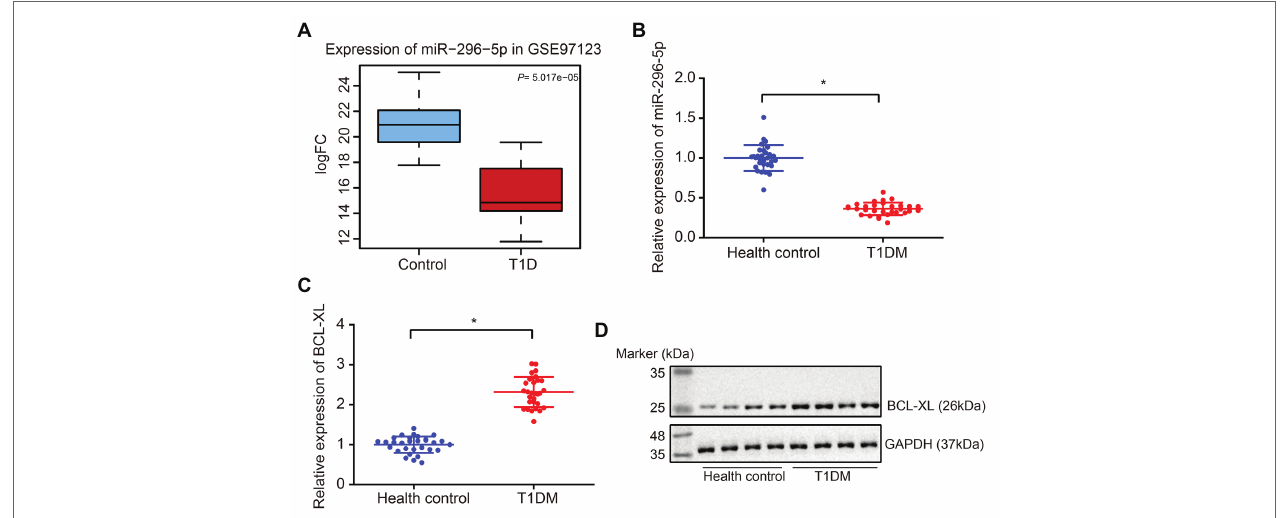
FIGURE 1 | Downregulation of miR-296-5p and upregulation of BCL-XL in peripheral blood mononuclear cells (PBMCs) of patients with Type 1 diabetes mellitus (T1DM) are observed. (A) Box plot of miR-296-5p expression in normal samples (blue box on the left) and in T1DM samples (right box on the right) from microarray dataset GSE97123. (B) The expression of miR-296-5p in PBMCs of patients with T1DM and healthy individuals determined by RT-qPCR. U6 was used as an internal reference. (C) The expression of Bcl-xl in PBMCs of patients with T1DM and healthy individuals determined by RT-qPCR. Gapdh was used as an internal reference. (D) The protein expression of BCL-XL in PBMCs of patients with T1DM and healthy individuals was determined by Western blot assay. GAPDH was used as an internal reference. * p < 0.05 compared with the control. The results were measurement data and expressed as mean ± standard deviation, and data comparison between two groups was performed using unpaired sample t -test, n =